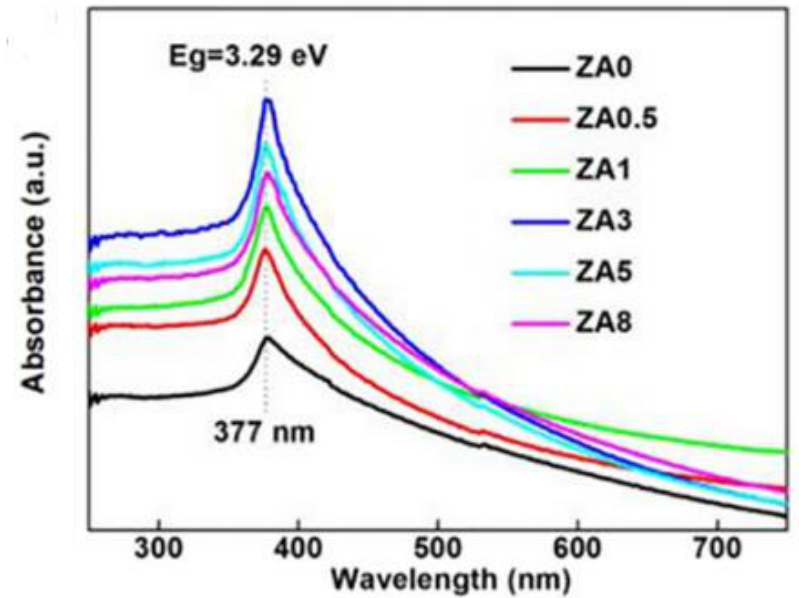
Figure 5. Absorption spectra of zinc oxide combined with different contents of silver.